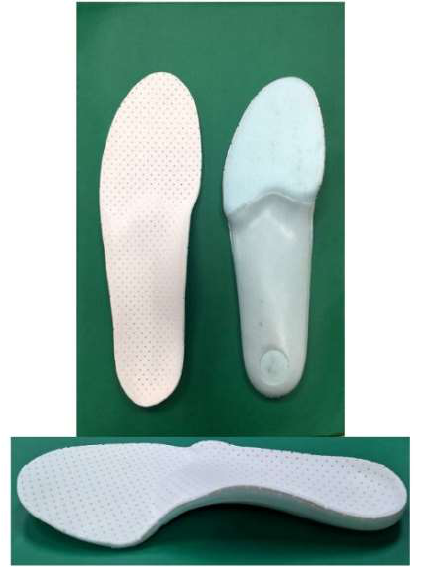
Figure 1. Positive foot mold for making customized foot orthosis.